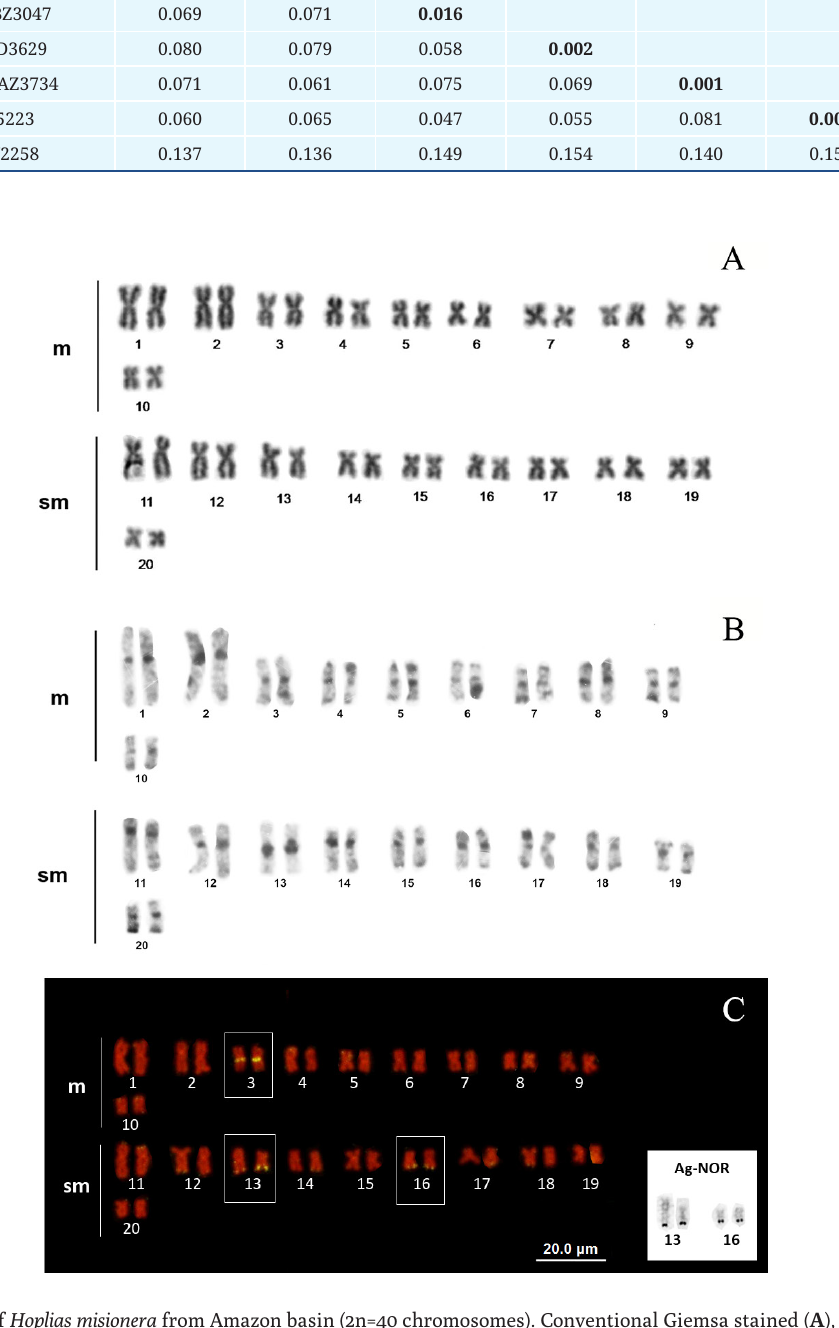
FIGURE 5 | Karyotype of Hoplias misionera from Amazon basin (2n=40 chromosomes). Conventional Giemsa stained ( A ), C-banded ( B ) and mapping of 18S rDNA FISH probes (green signals) ( C ). The Ag-NOR bearing chromosomes are showed in the